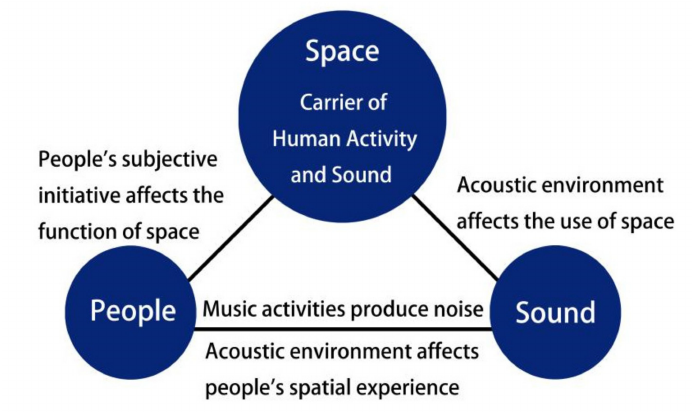
Figure 1. Relationship model of people, sound, and